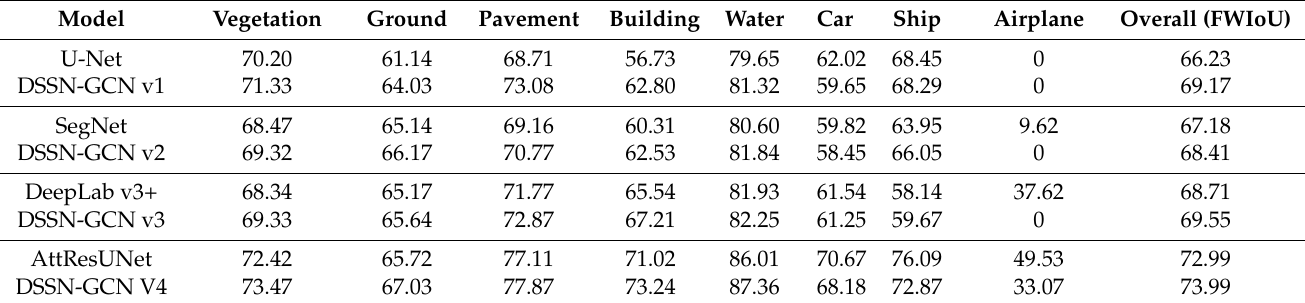
Table 5. The intersection over union (IoU) (%) of semantic segmentation on the UCM dataset.